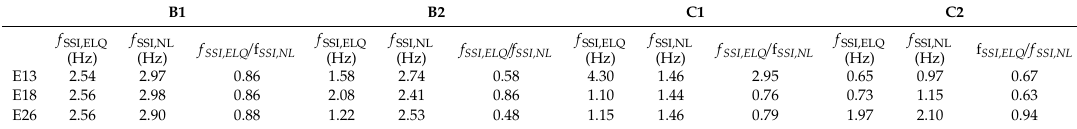
Table 6. Comparison between the soil fundamental frequencies for the two models (ELQ and NL). B1 B2 C1 C2 f SSI,ELQ